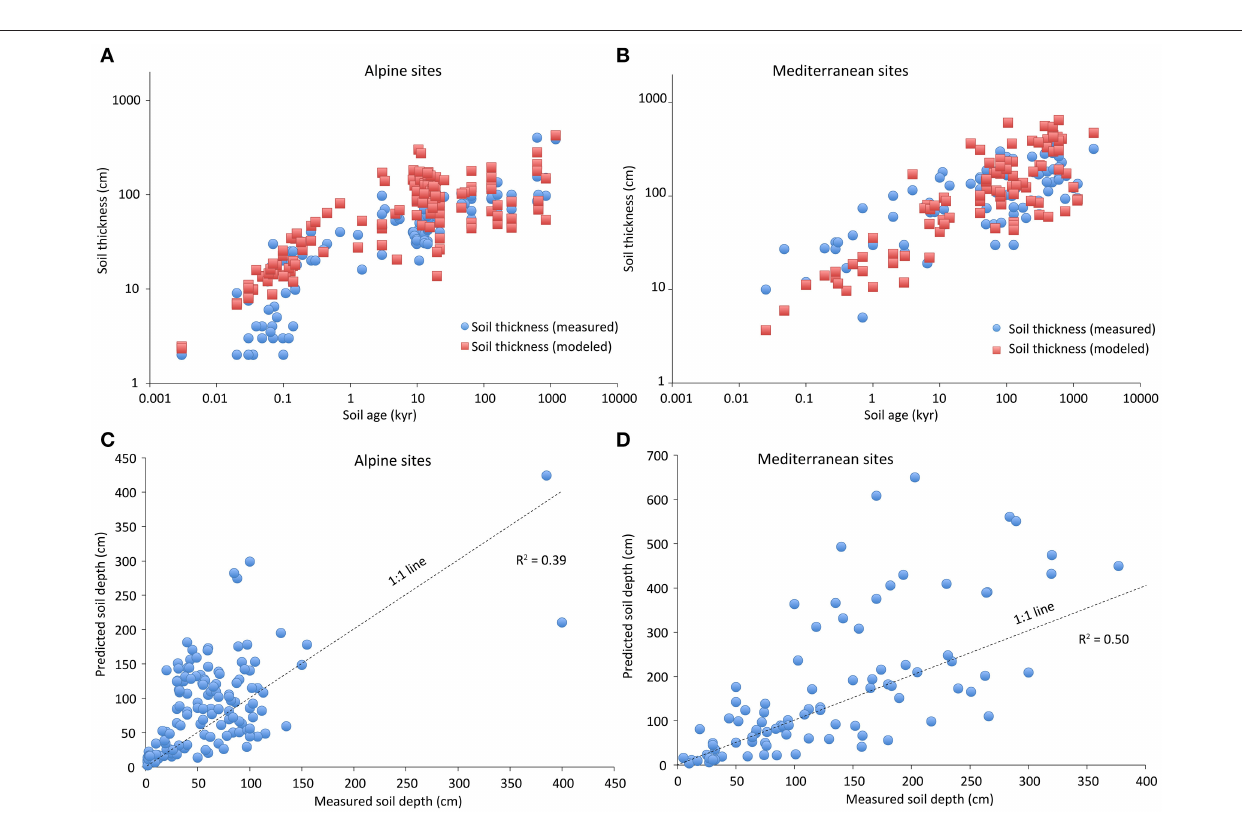
FIGURE 7 | Time trends of modeled and measured soil thickness for the distinct geographic regions, (A) alpine soils, (B) Mediterranean soils, and correlation between predicted and measured soil depth for (C) alpine and (D) Mediterranean